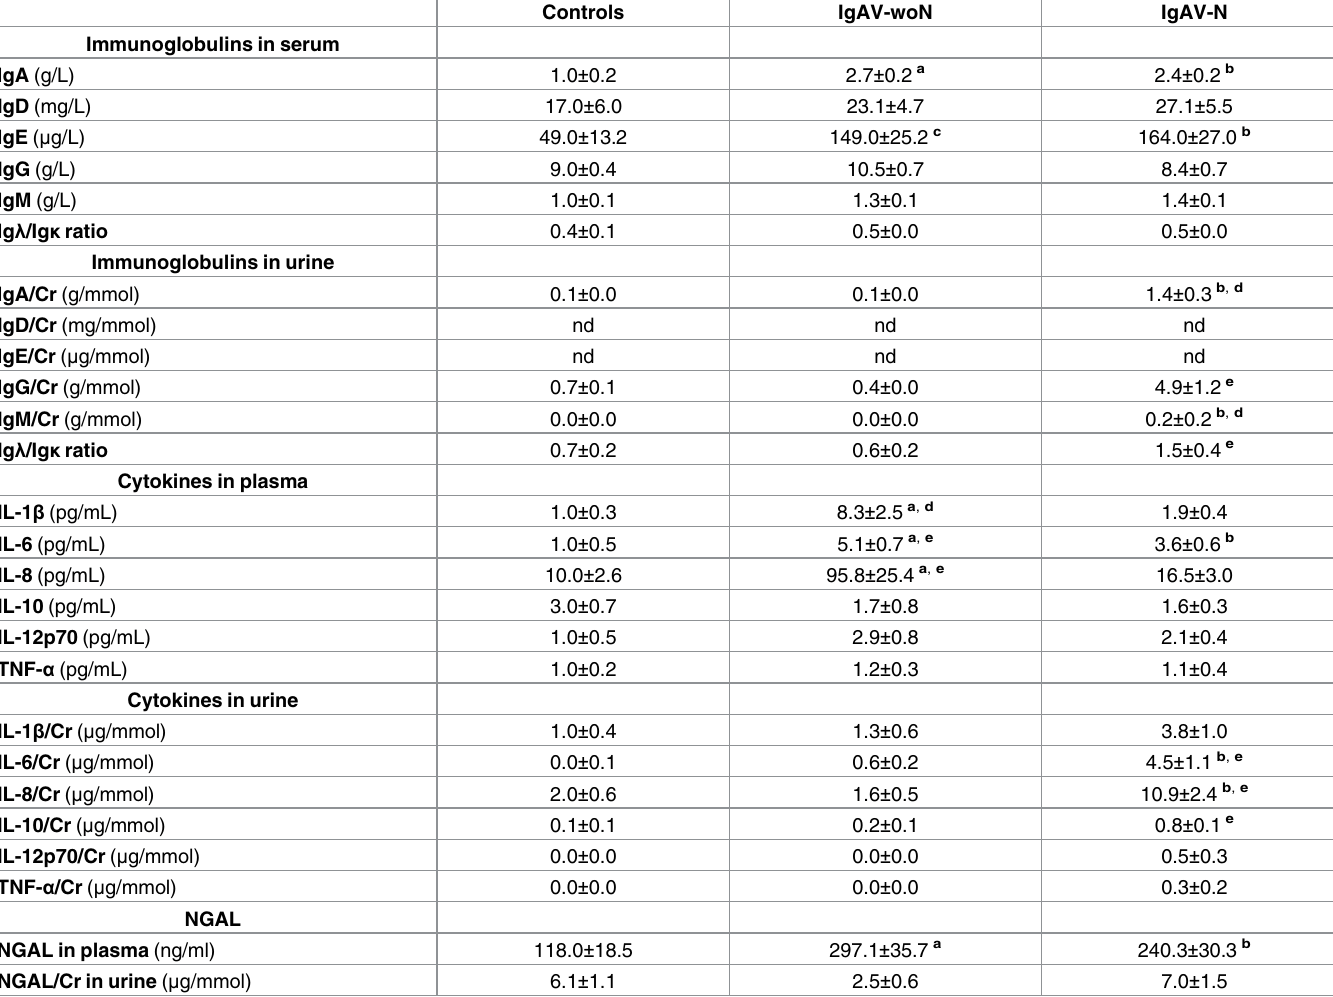
Table 3. Biomarkers in the circulation and urine of pediatric patients and controls at the time of purpura rash (day 1). Controls IgAV-woN